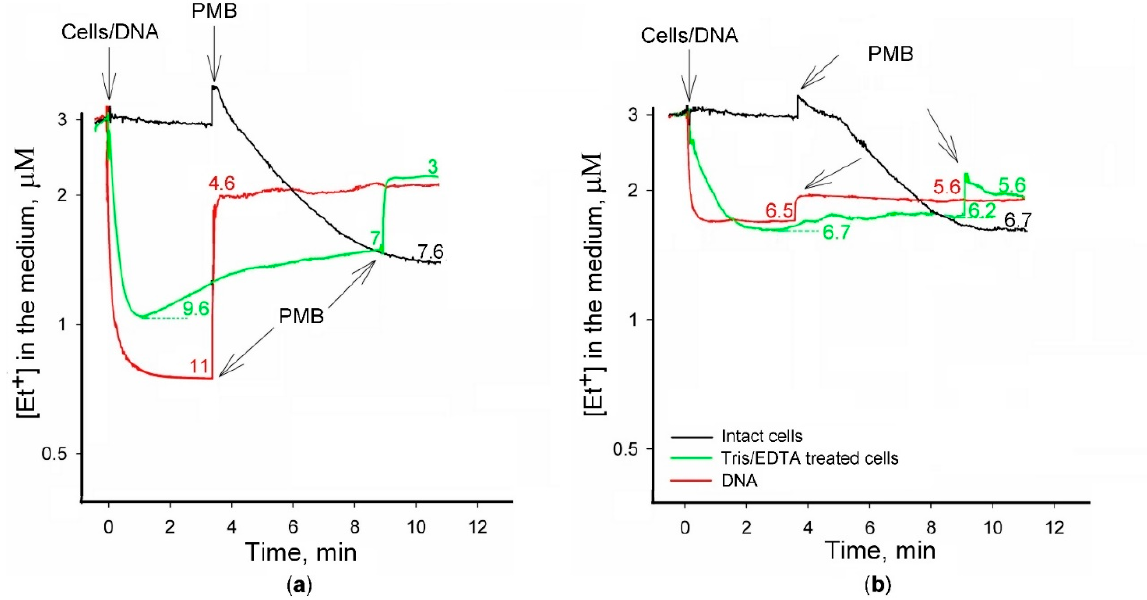
Figure 3. The binding of Et + to intact or Tris/EDTA-permeabilized S. typhimurium SL1344 wt cells and salmon sperm DNA. The experiments were performed at 37 ◦ C in 100 mM ( a ) or 400 mM ( b ) Tris/HCl buffer, pH 8.0, containing 0.1% glucose. Concentrated suspensions of intact or Tris/EDTA-treated cells were added to obtain OD 600 of 1. Red curves demonstrate the addition of 100 µ g of salmon sperm DNA. PMB was added to the final concentration of 50 mg/L. Numbers next to the curves indicate the amount (nmol) of Et + bound.